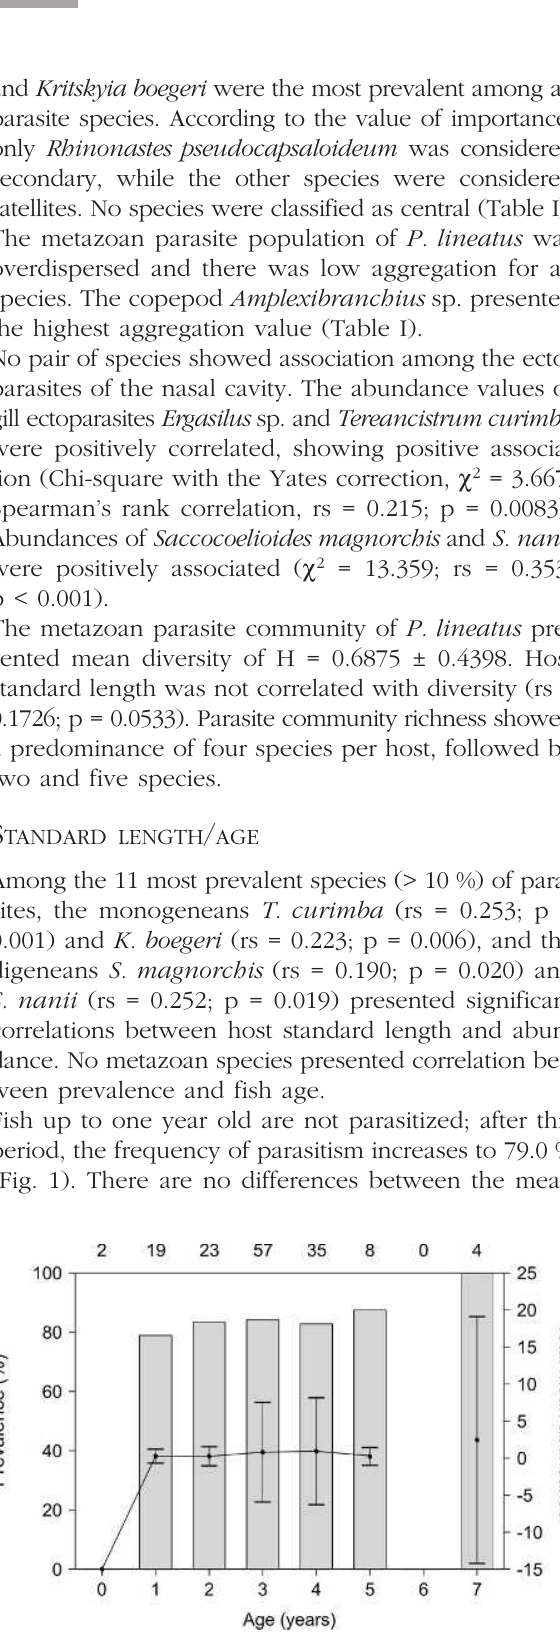
Fig. 1. – Frequency of parasitism for each age class of Prochilodus lineatus , captured on the upper Paraná River floodplain from February 2000 to June 2001 (Numbers on the top of the graph refer to the number of examined